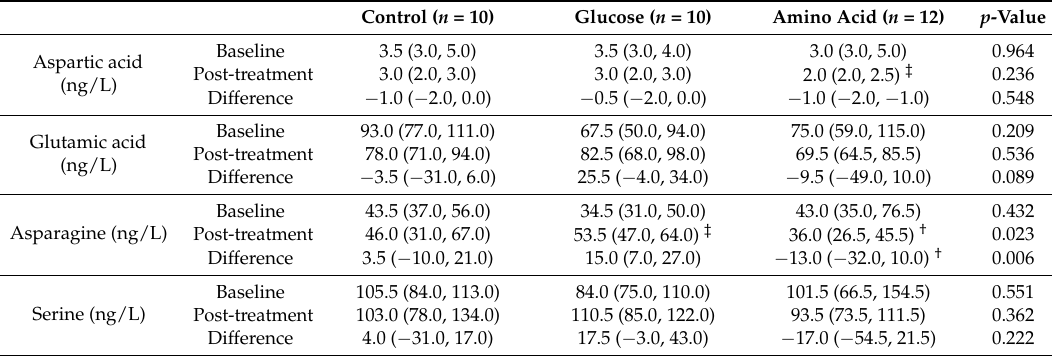
Table 4. Comparison of median amino acid concentrations for the three treatment